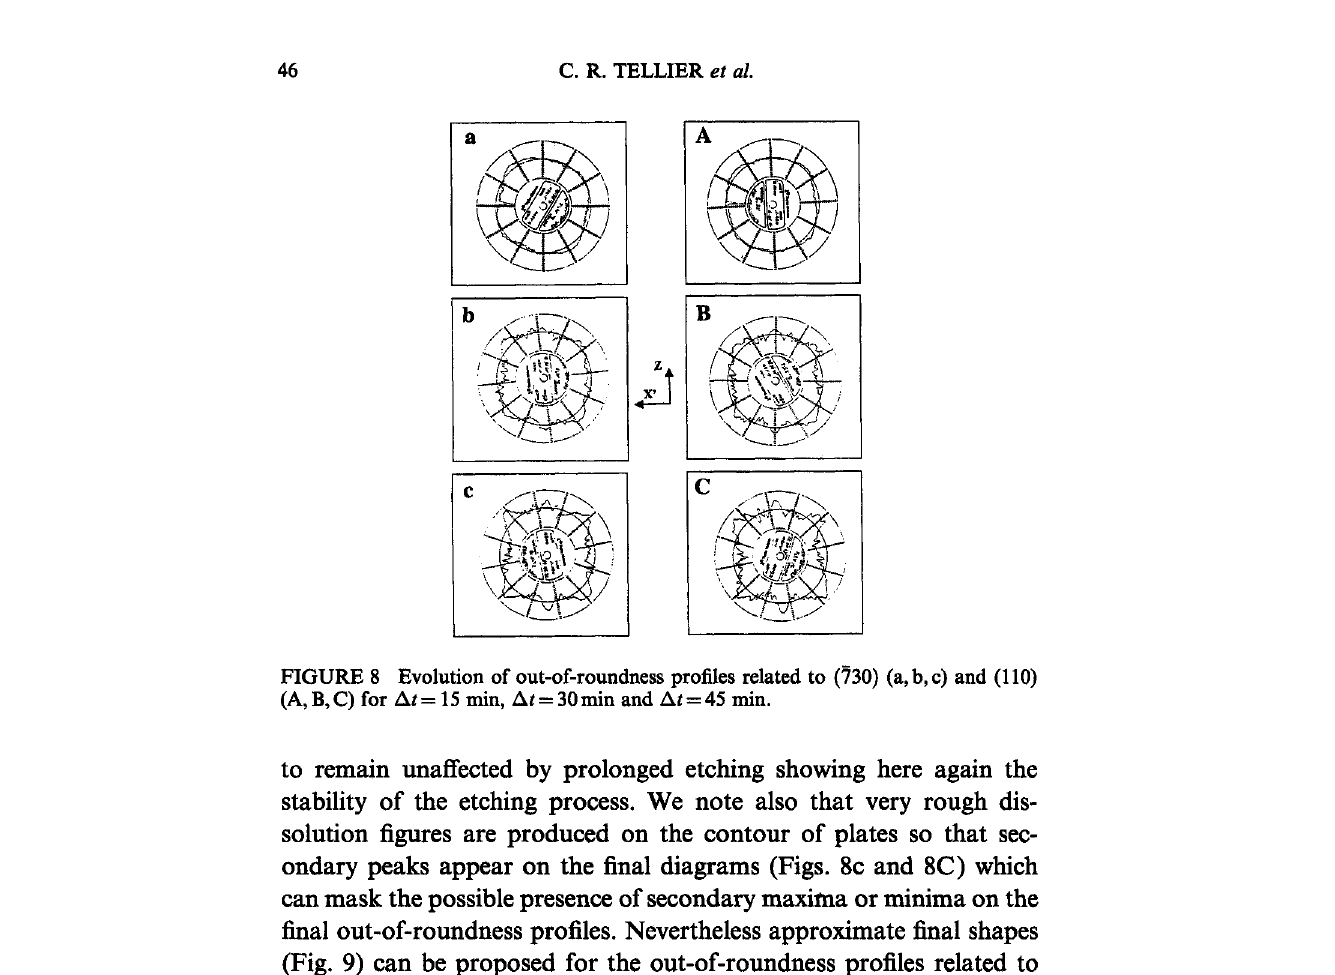
FIGURE 8 Evolution of out-of-roundness profiles related to (30) (a,b,c) and (110) (A,B, C) for At= 15 min, At= 30min and At=45